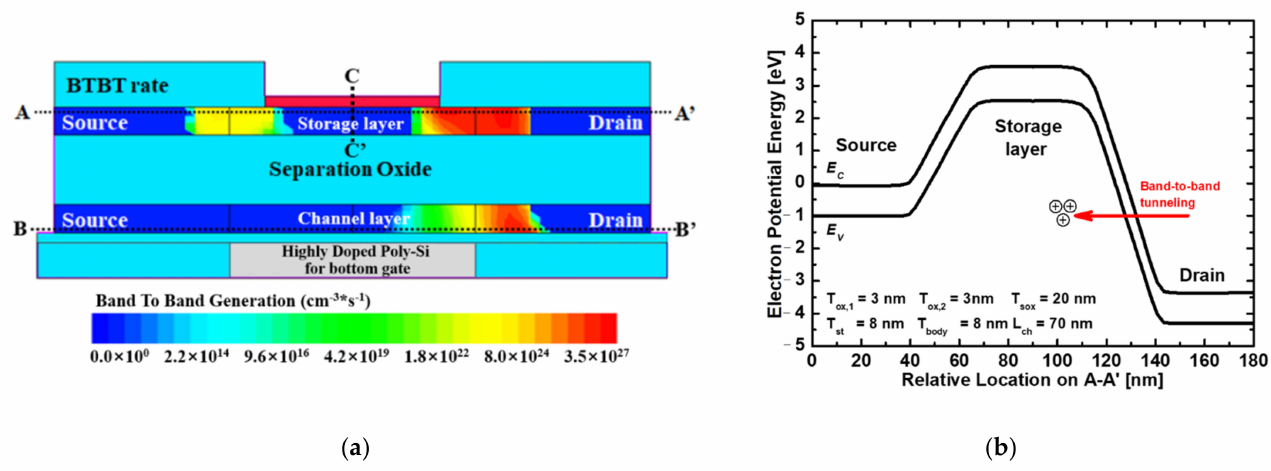
Figure 5. ( a ) Simulation profiles of the proposed 1T-DRAM during the program operation showing BTBT rate. ( b ) Energy band diagram of the storage layer. The energy band is extracted at 2 nm below the top gate